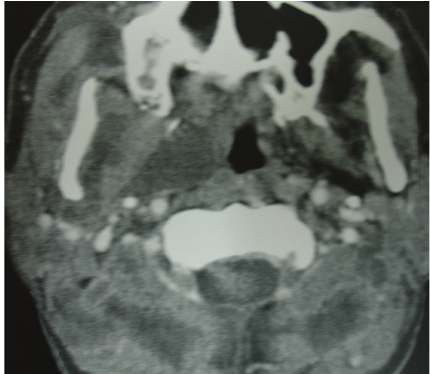
Figure 2: Neck CT scan of the case shows multiple cystic lesions in the neck and right parapharyngeal